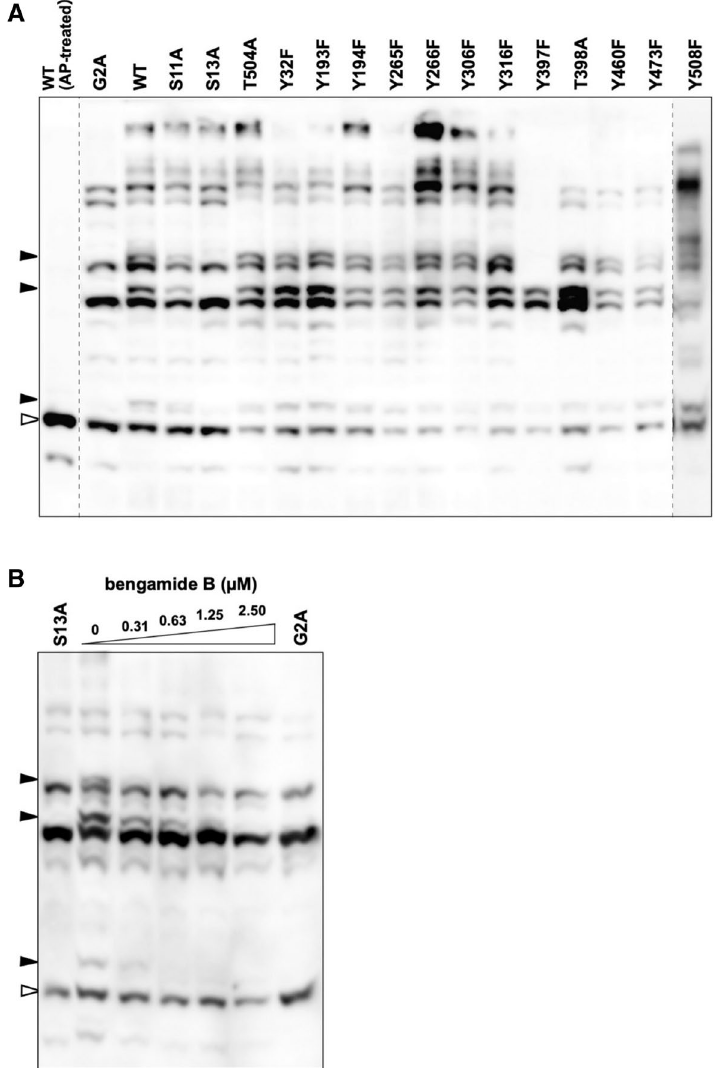
Figure 2. Identification of a specific N-myristoylation-dependent phosphorylation site of Lyn. ( A ) FLAG- tagged Lyn (WT), its G2A mutant, and the 15 site-directed mutants expressed in HEK293 cells were analyzed by Phos-tag SDS-PAGE (20 mM Zn 2+ –Phos-tag and 7% w/v polyacrylamide) followed by immunoblotting with anti-FLAG antibody. AP alkaline phosphatase. Raw image data for the three full-length blots shown in Supplementary Figure S7A have been spliced to arrange the lanes appropriately. The positions of the splices are indicated by vertical dashed lines. ( B ) FLAG-tagged Lyn (WT) expressed in HEK293 cells treated with bengamide B (0–2.50 µM) were analyzed by Phos-tag SDS-PAGE (20 μM Zn 2+ –Phos-tag and 7% w/v polyacrylamide) followed by immunoblotting with anti-FLAG antibody. The S13A (leftmost lane) and G2A mutants (rightmost lane) were loaded for reference purposes. Open arrowheads: nonphosphorylated species; closed arrowhead: phosphospecies containing a phosphorylated Ser-13 residue. The raw image is shown in Supplementary Figure